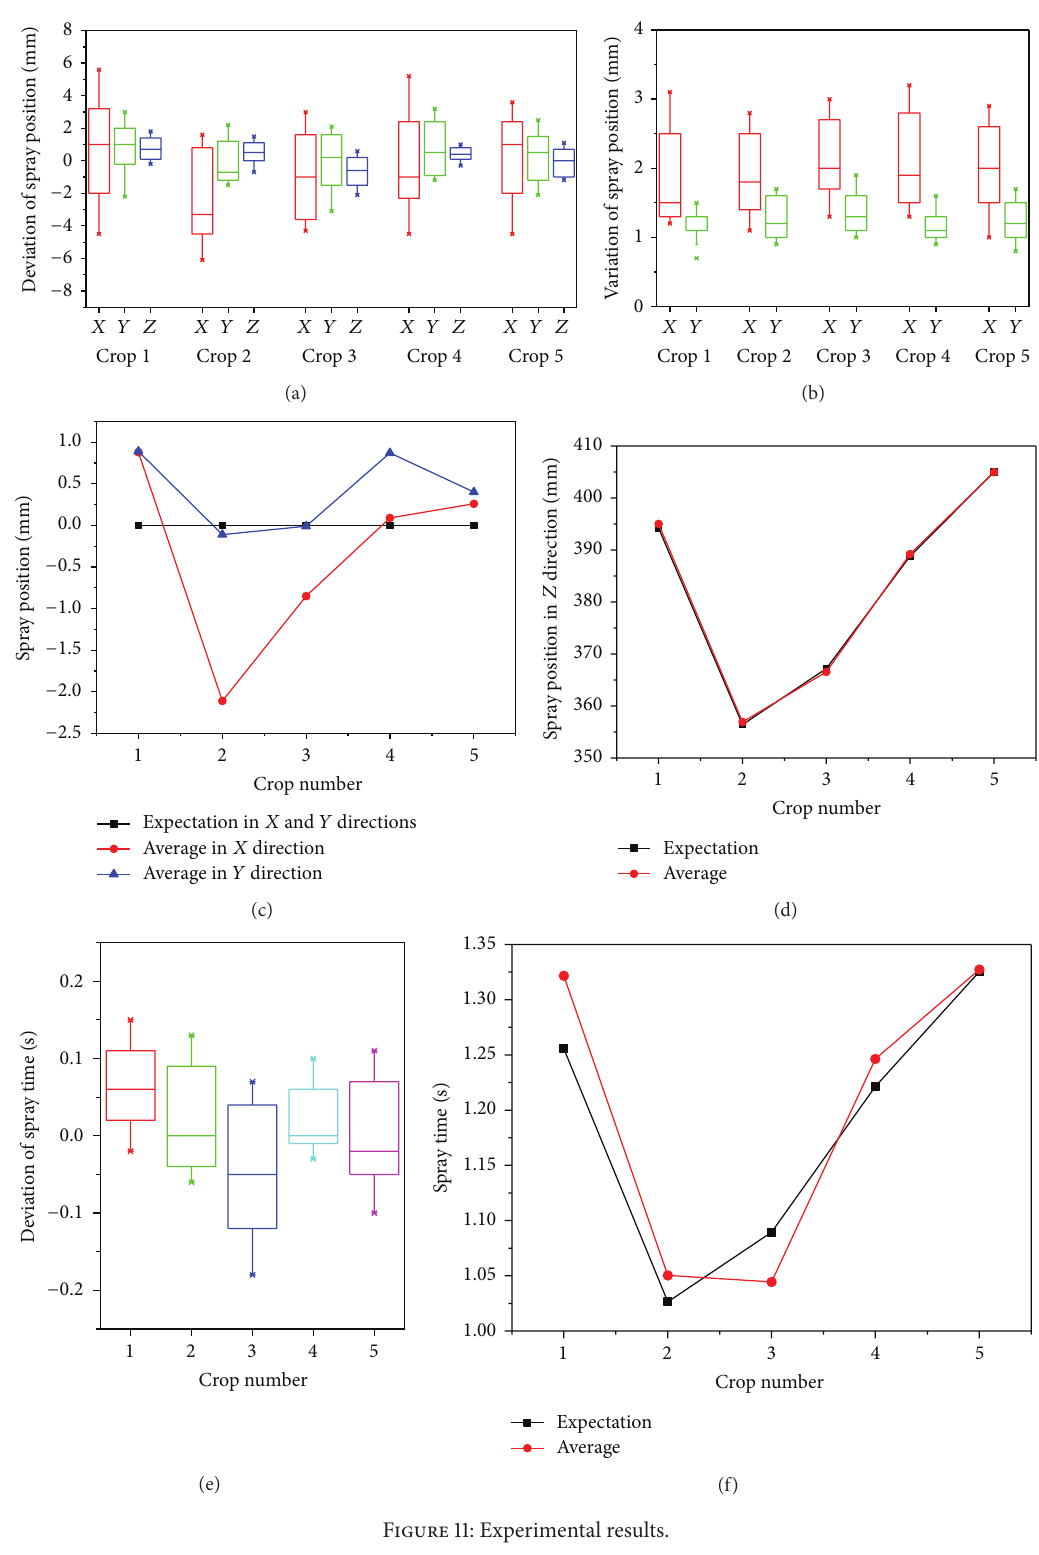
Figure 11: Experimental